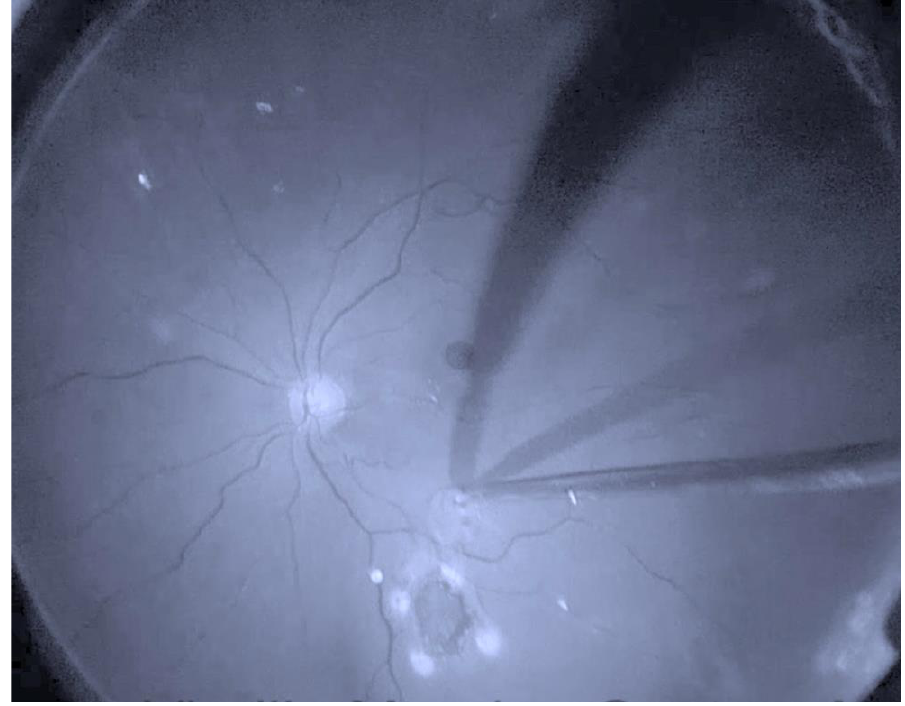
Figure 1. Retinal graft is displaced using ILM (Internal Limiting Membrane) forceps.